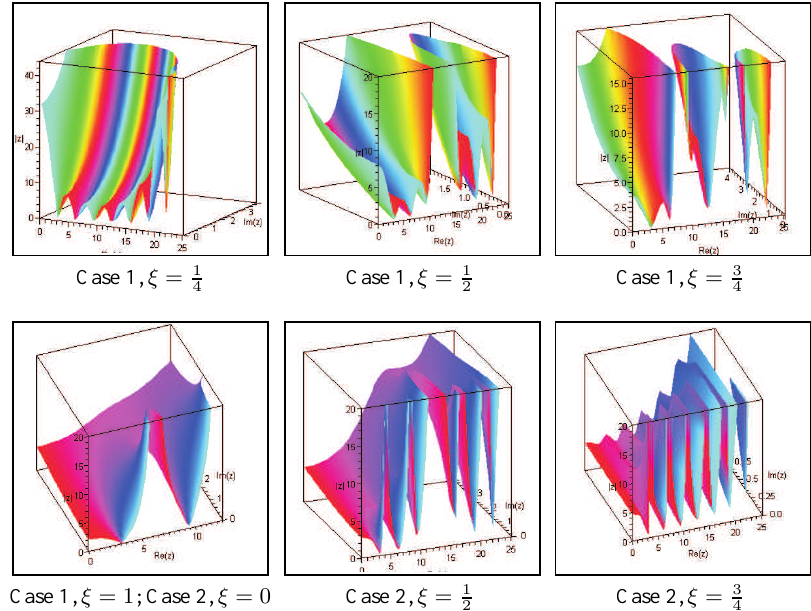
Figure 1. Functions j (cid:13) 1 r ( z=(cid:25) ) j and j (cid:13) 2 r ( z=(cid:25) ) j for various (cid:24)